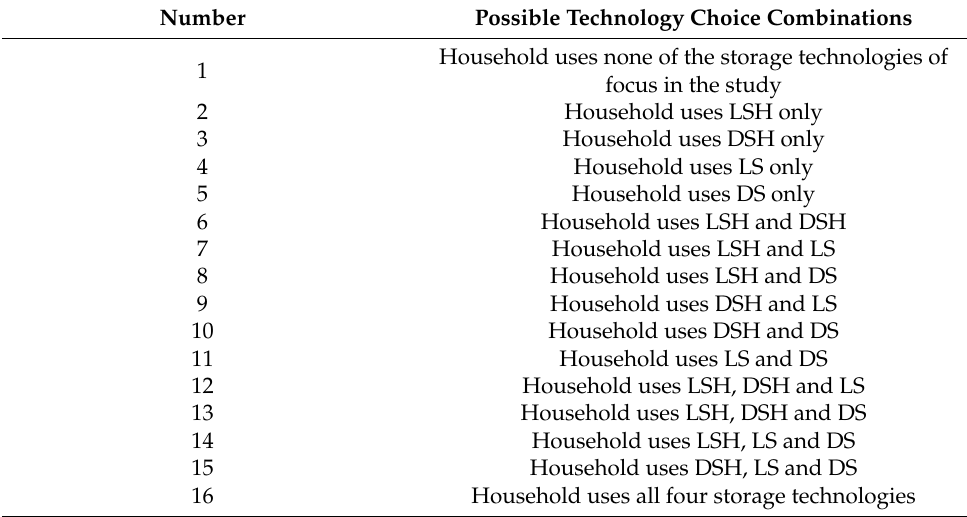
Table 1. Possible storage technology choice